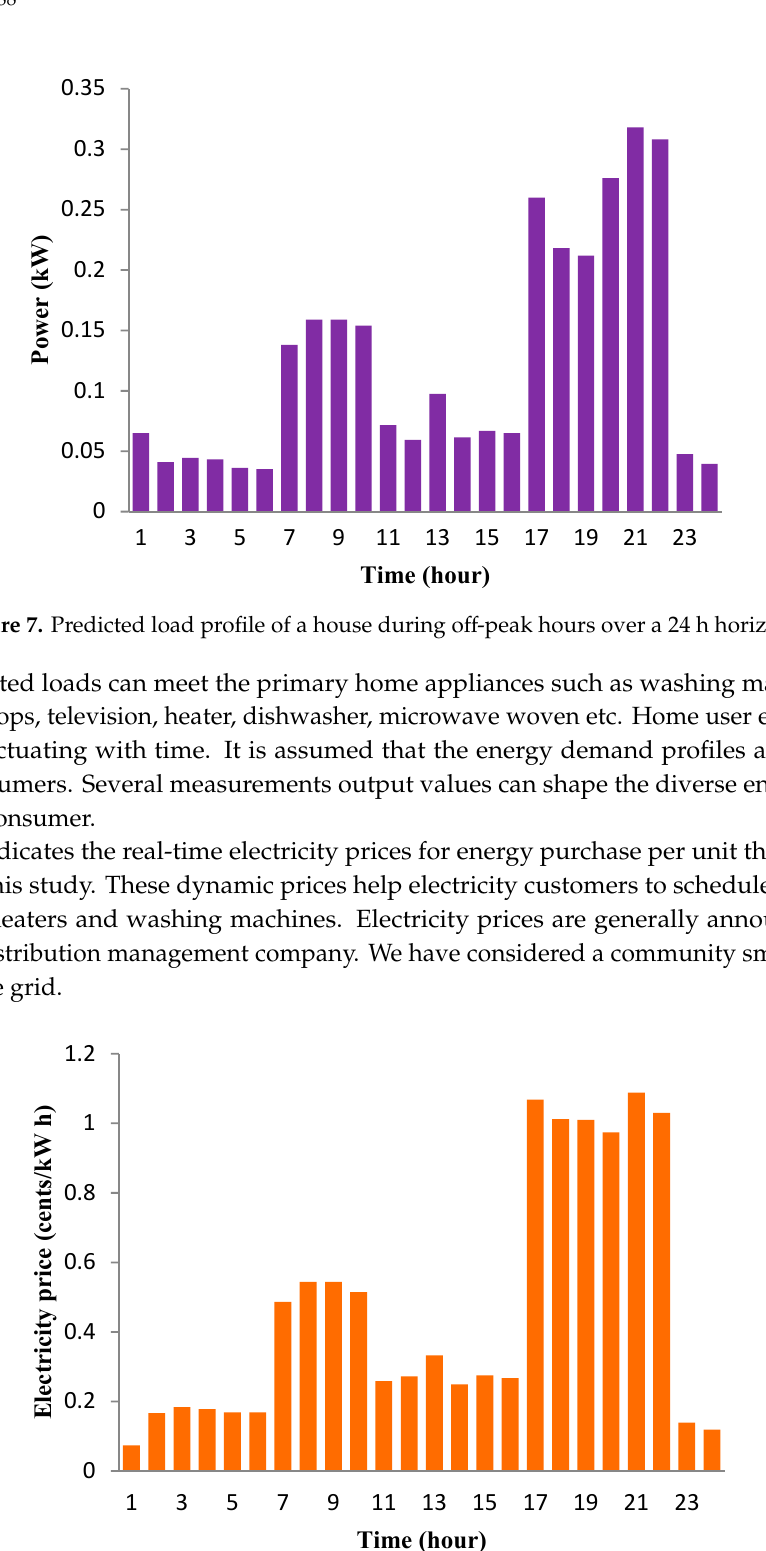
Figure 6. Predicted load profile of a house during mid-peak hours over a 24 h horizon .